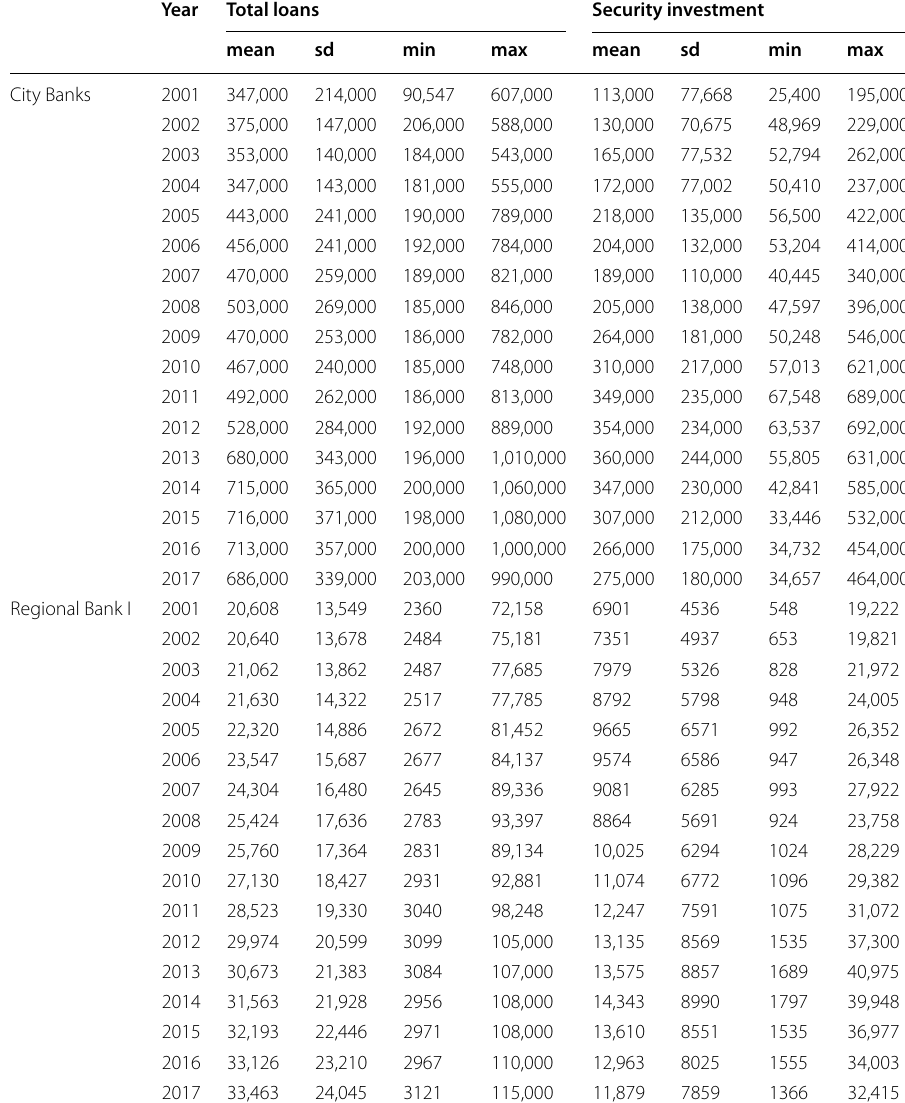
Table 5 Summary of bank main activities (amount in 100millions of